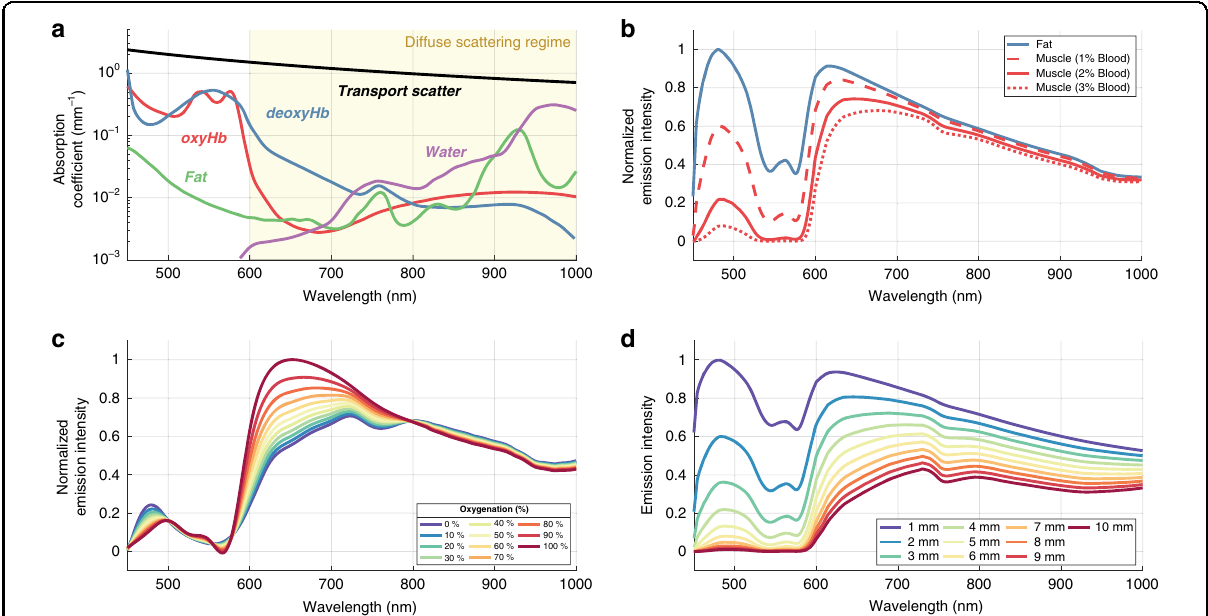
Fig. 2 Cherenkov light transport in tissue. The spectrum of light emitted from tissue is predominantly affected by the absorption bands from oxyhemoglobin, deoxyhemoglobin, water, and lipids, and the overall tissue scattering spectrum, shown in a . The calculated Cherenkov emission from 5 mm depth in fatty (90% fat/9.5% water/0.5% blood (0.25% Hb/0.25% HbO 2 )) and radiodense (water and blood in varying percentages with equal weight to Hb and HbO 2 ) tissues are shown in b , whereas biological changes in blood oxygenation in radiodense tissue (2% blood) a will alter the Cherenkov emission spectrum due to differences in absorption between oxy- and deoxyhemoglobin c . Lastly, varying the depth of emission in radiodense tissue (2% blood) effects the Cherenkov emission spectrum at the surface ( d